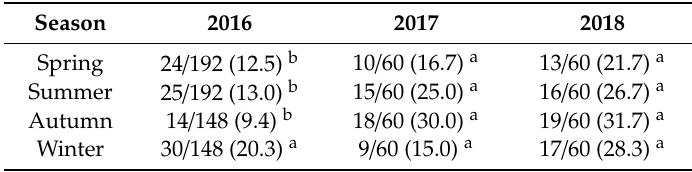
Table 2. Seasonal e ff ect on Salmonella prevalence per